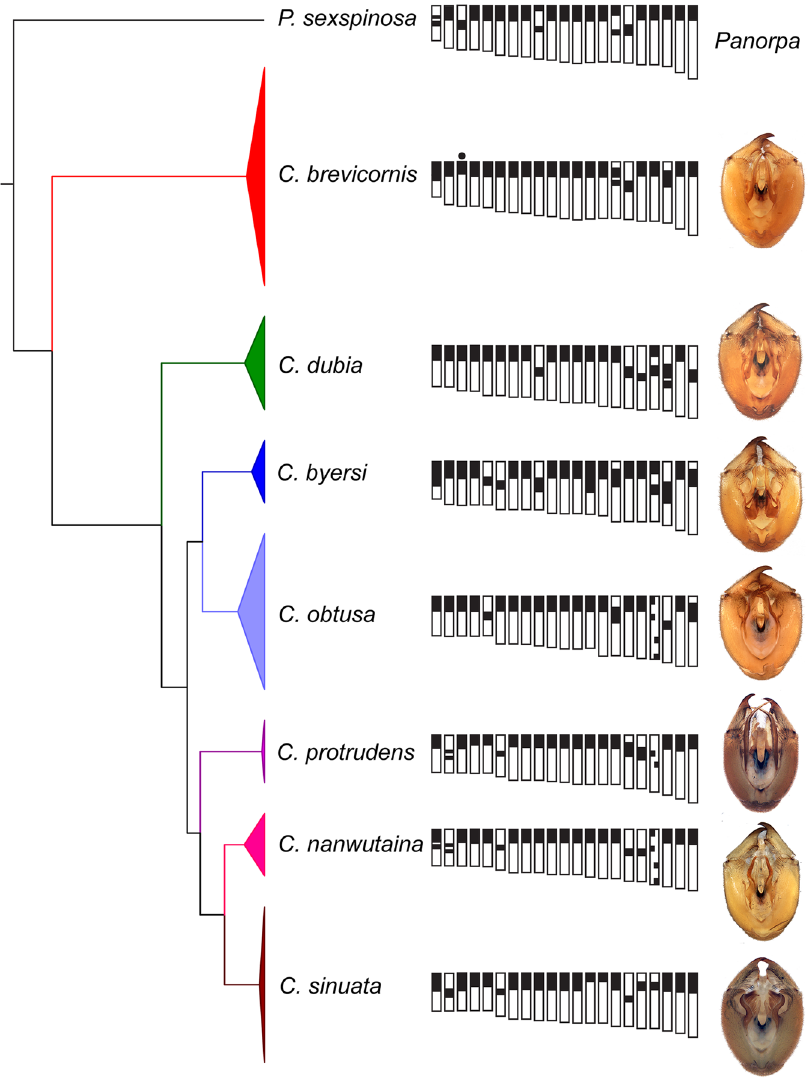
Figure 2. Phylogenetic relationship of the seven species in Cerapanorpa with the schematic representation of the main C-bands (black blocks) and the male genitalia in ventral